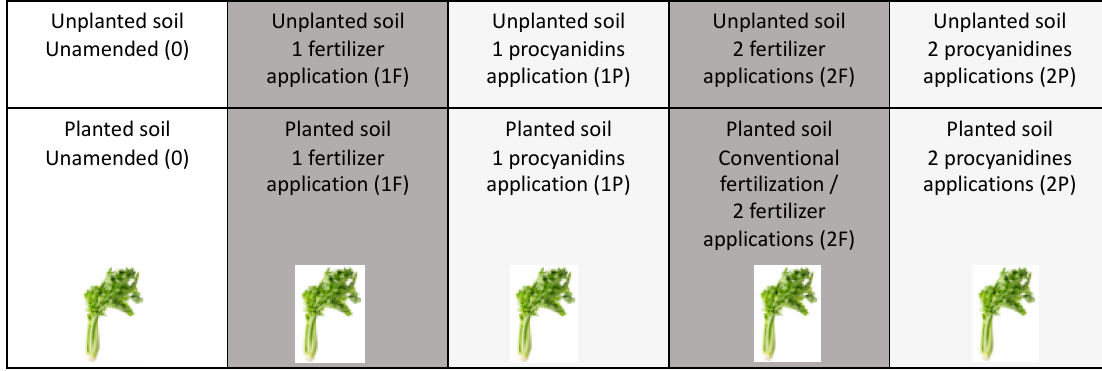
Figure 1. Summary diagram of the experimental design. Unamended (0), one fertilizer application (1F), two fertilizer applications (2F), one procyanidin application (1P), and two procyanidin applications (2P), for unplanted and planted plots, with a replicate number of three ( × 3), following a Fisher model.